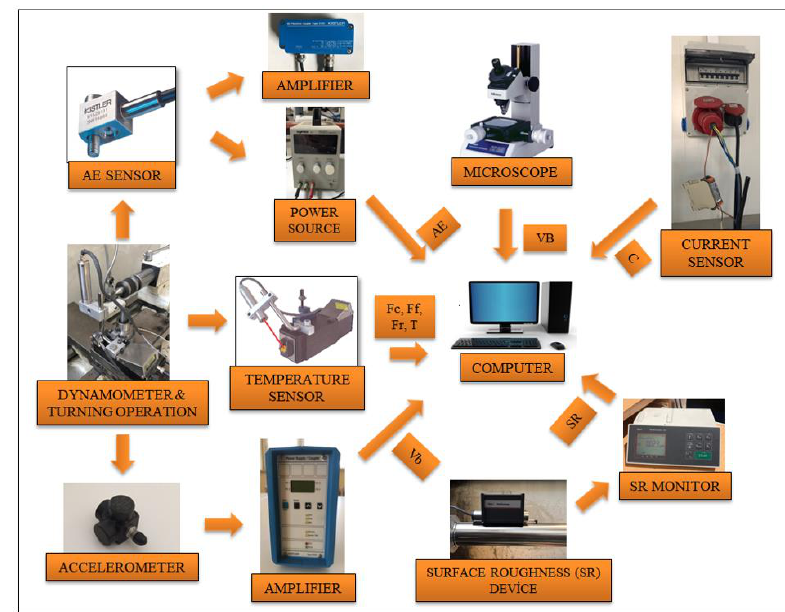
Figure 2. An example for an indirect tool condition monitoring system [5].